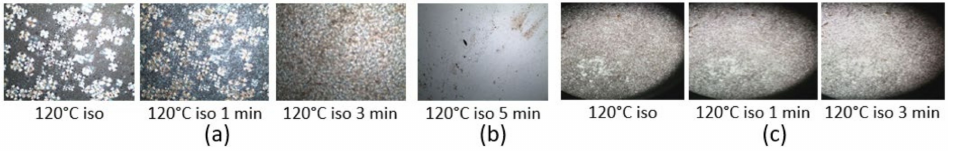
Figure 9. POM micrographs taken during isothermal crystallization, at 120 ◦ C, of base-PLLA (P b ) ( a ), stereo-complexer PDLA (P m1 ) ( b ) and resulting stereo-complexed compound sc-1 ( c ).